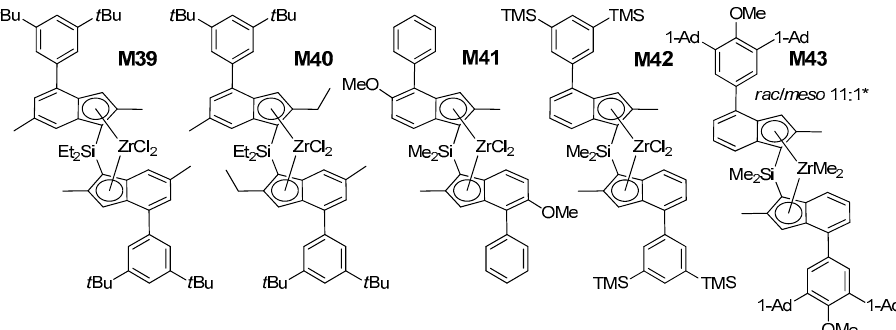
Figure 6. Structures of M39–M43 (Ad = Adamantyl). * M43 could not be further purified. The influence of varying the bridge from SiMe 2 to SiEt 2 is negligible within the experimental error margins [13].